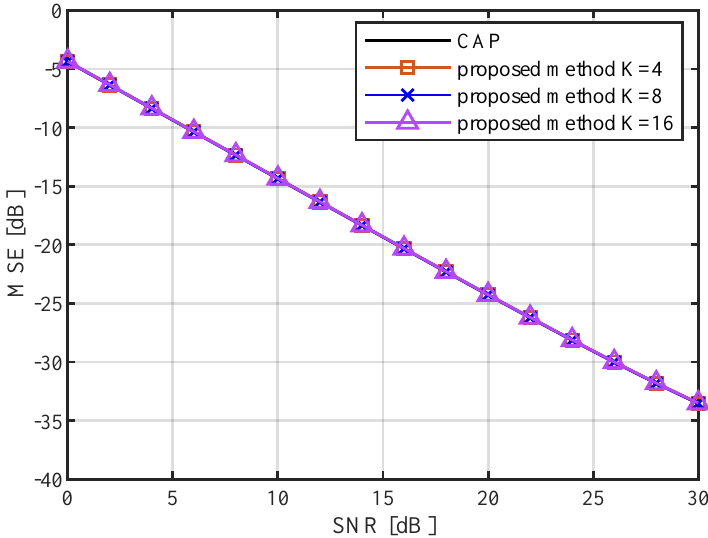
Figure 7. Zoomed-in version of a portion of Figure 6.